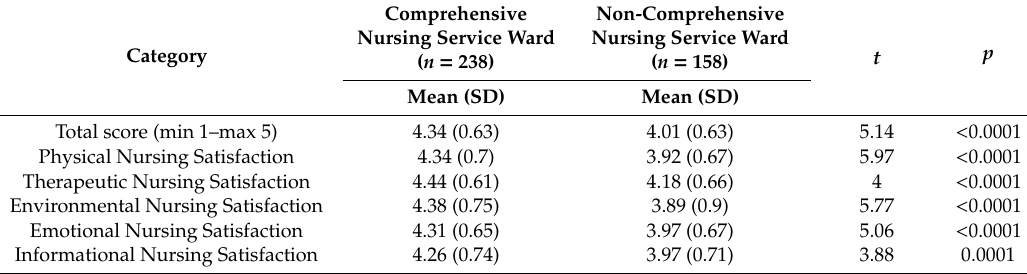
Table 5. Patient Satisfaction Scores ( n = 396).